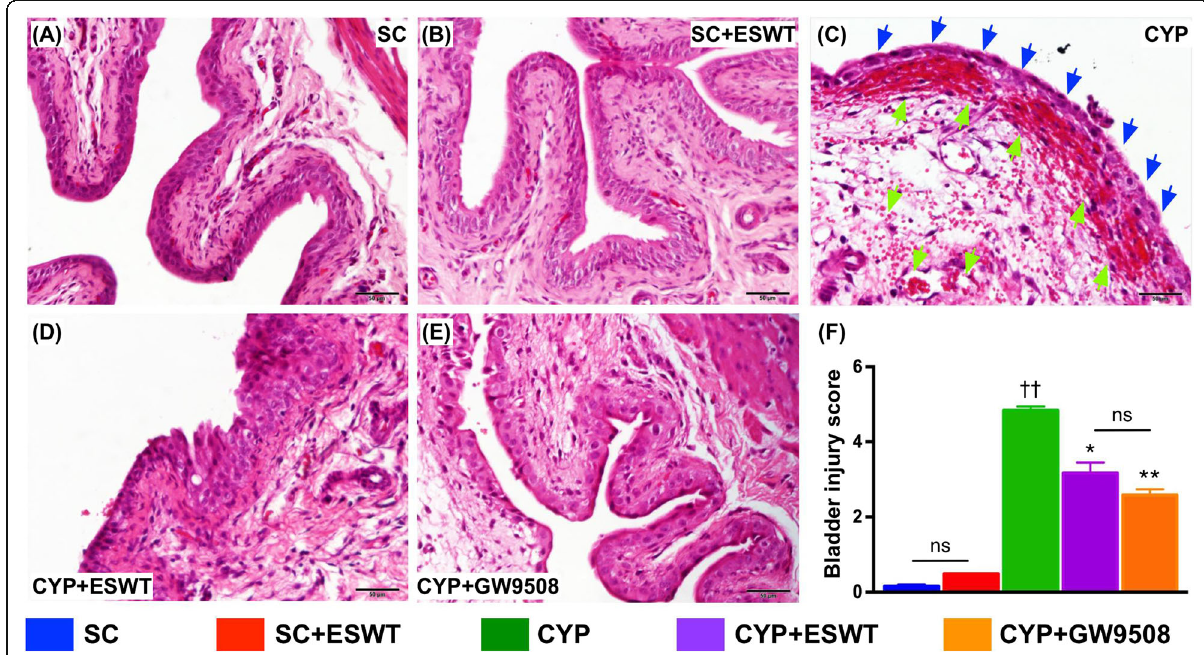
Fig. 6 Histological distortion of urinary bladder in rats following cyclophosphamide (CYP) stimulation with and without GPR120 agonist / extracorporeal shock wave treatment (ESWT). Hematoxylin eosin (H&E)-stained bladder sections showing normal urothelium in sham controls with ( a ) and without ( b ) ESWT. Damaged urothelium noted in rats following CYP treatment ( c ), including mucosal thinning. (blue arrows) and edematous lamina propria with inflammatory cell infiltration (green arrows). Significant preservation of urothelial integrity after ESWT ( d ) and GPR120 agonist (i.e., GW9508) ( e ) treatment. f Summary of differences in bladder injury score in the five groups of animals ( n = 6 per group). Values expressed as the mean ± SEM. * p < 0.05, ** p < 0.01 vs. CYP; †† p < 0.01 vs. controls; ns, non-significance. Significance of differences determined by one-way ANOVA followed by Bonferroni ’ s post-hoc comparisons tests. Scale bars in right lower corner represent 50 μ m. SC = sham control; CYP = cyclophosphamide; ESWT = extracorporeal shock wave treatment; GW9508= GPR120